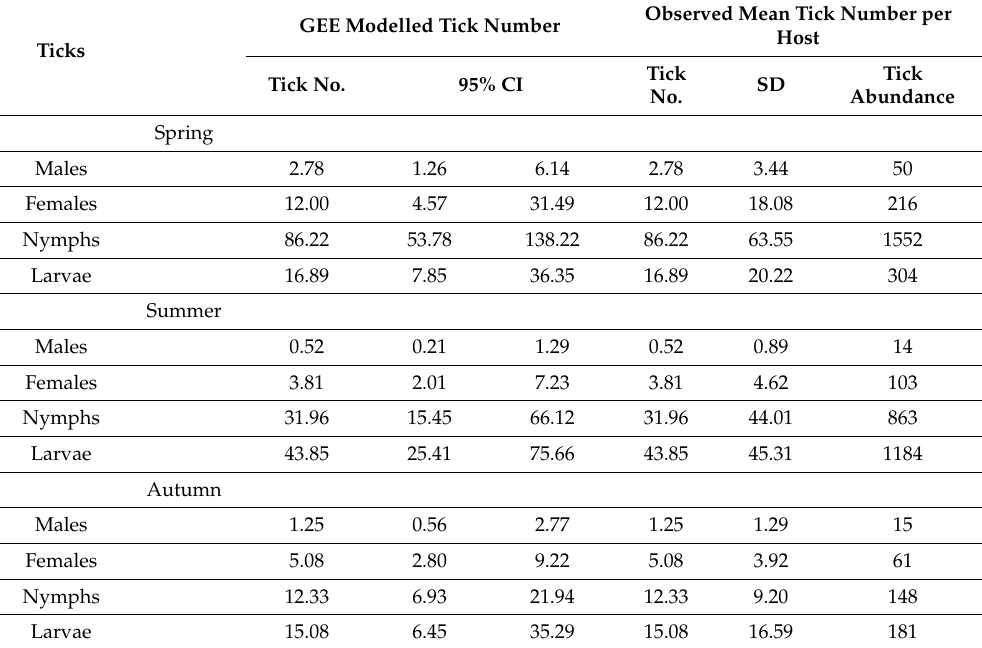
Table 2. Comparison of observed and modelled mean Ixodes ricinus numbers per hedgehog. The applied statistical model was a marginal generalised linear model fitting Poisson distribution.